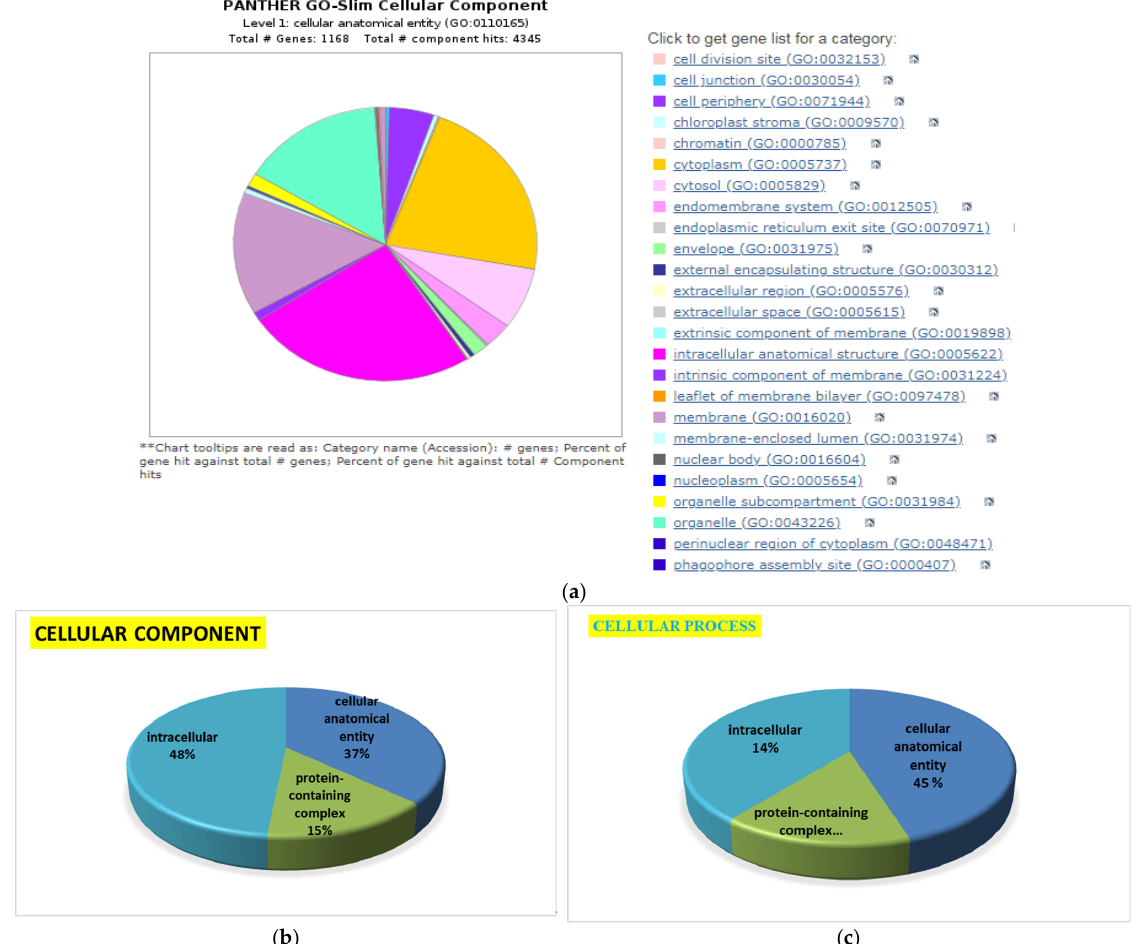
Figure 9. Gene Ontology classification of proteins: ( a ) process hits, ( b ) HBGH35, and ( c ) Pusa Naveen ( ♀ ) based on their cellular level